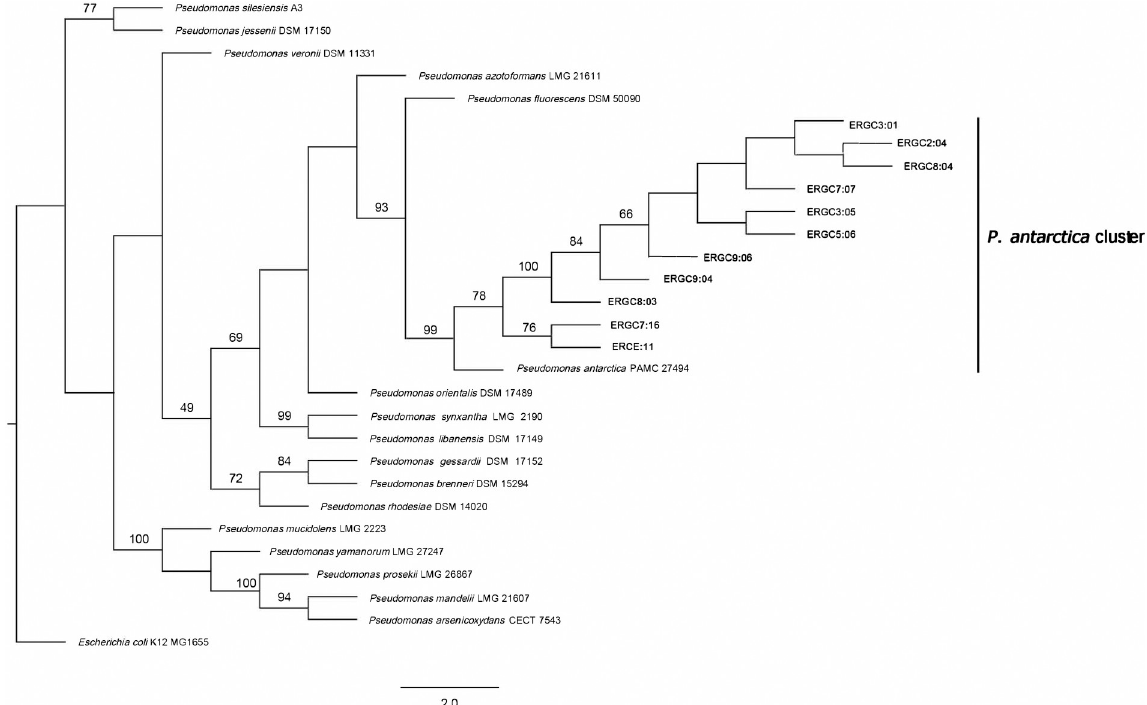
Fig 3. Phylogenetic tree of 11 Pseudomonas study strains based on the concatenated sequences of protein-coding genes gyrB-ileS-nuoD- recA-rpoD using RAxML. Support values are calculated from 1000 rapid bootstrap replicates (BT). BT values of 50 or more are indicated at branching points. The scale bar corresponds to the average number of nucleotide substitutions per site. Our test strains are marked in bold, that form a separate cluster with P . antarctica PAMC 27494. E . coli K12 MG1655 was used as the outgroup organism. Partitionfinder v2.1.1 was used to determine the best-fit partitioning schemes and substitution models of molecular evolution.